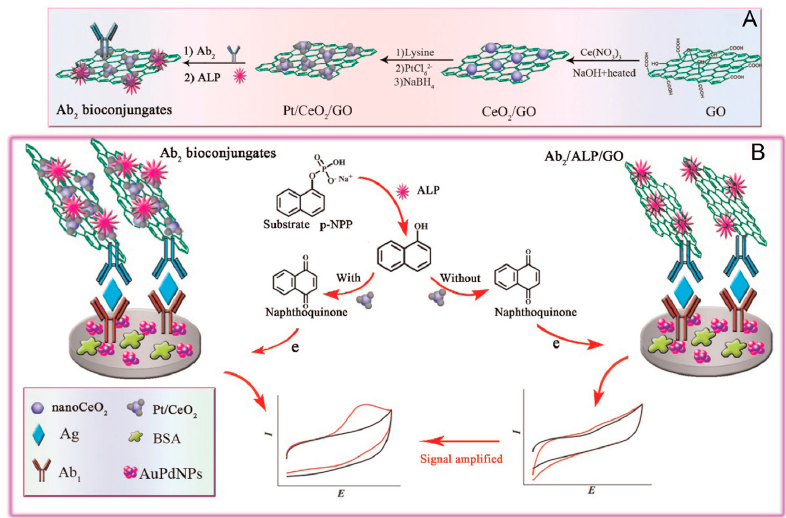
Figure 9. Schematic illustration of: ( A ) the step wise preparation procedure of PtNPs/CeO 2 NPs/GO composites used as signal probes and ( B ) the amplification mechanism of detection signal at an Ab 1 - AuPdNPs/GCE: ALP catalyzes the dephosphorylation of 1-NPP substrate giving naphthoquinone which is electrochemically reduced onto the immunosensor prepared with Ab 2 /ALP/PtNPs/CeO 2 NPs/GO (current amplification) or Ab 2 /ALP/GO (no amplification). Cyclic voltammograms in absence (black) and in the presence (red) of antigen (Ag). Reprinted from [65] with permission.